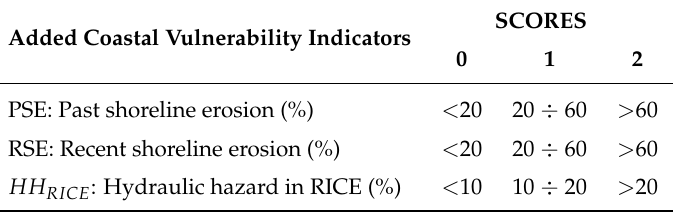
Table 2. Ranking scores of modified/added CVI indicators.